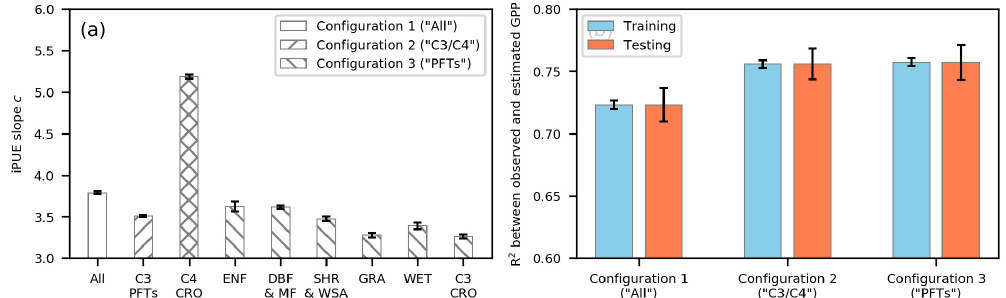
Figure 11. Statistics of the SANIR V –iPUE relationship from cross validation. (a) Slopes of the SANIR V –iPUE relationship over different subsets. (b) R 2 between AmeriFlux GPP and estimated GPP using different model configurations for the training and testing datasets, respectively. Error bars in both subplots indicate 95% confidential intervals over 500 experiments.